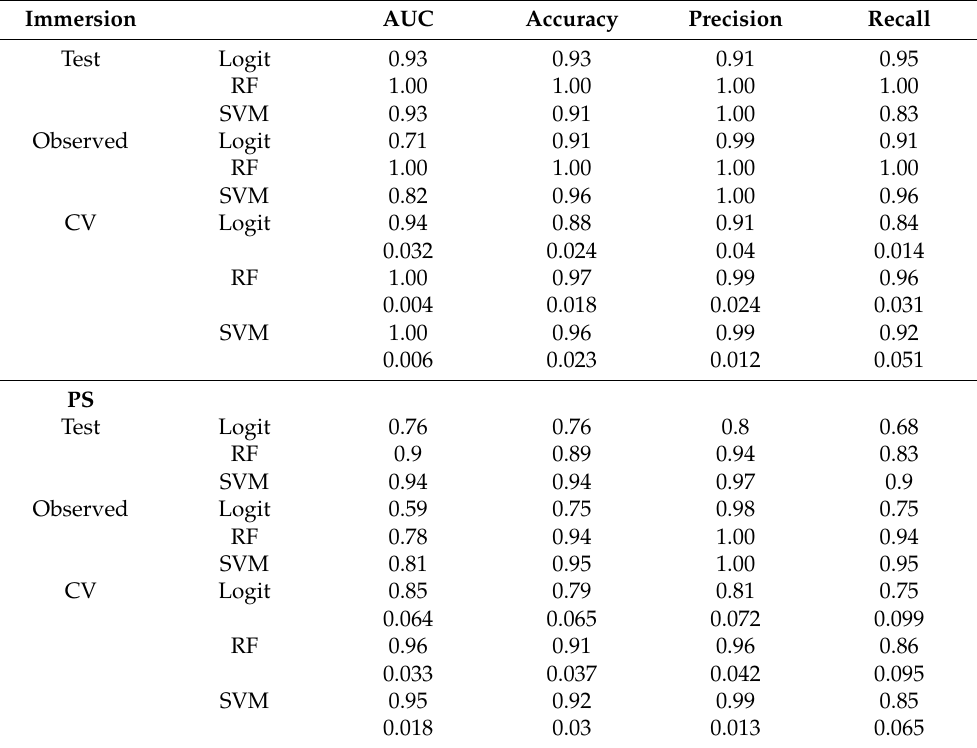
Table A8. ML classification of Mood using Immersion and PS in regularized logit, random forest (RF), and support vector machine (SVM) estimations. CV is cross-validation.